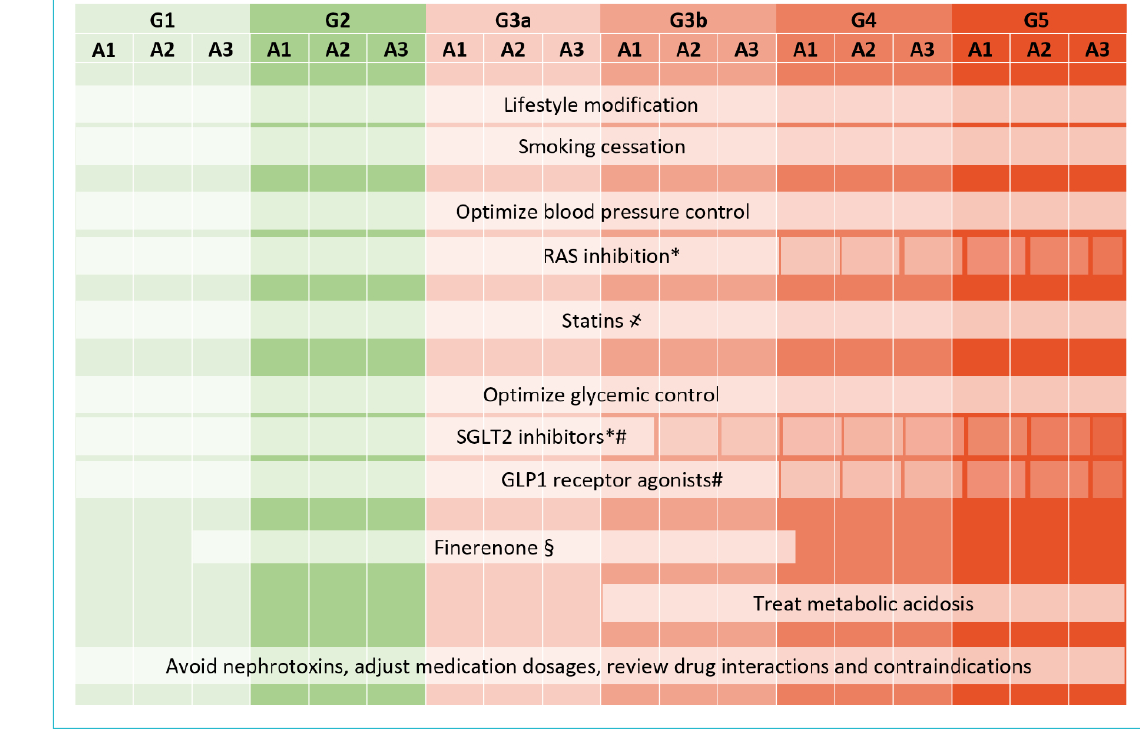
stage A3. # SGLT2i and GLP1Ra decrease renal and cardiovascular morbidity in high CV risk patients. § Cardiovascular and renal protection with finerenone in albuminuria stage A2 and